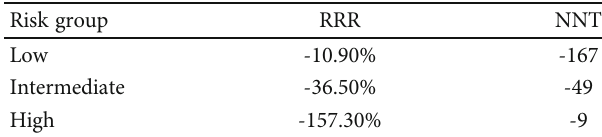
Table 13: Assessment of the utility of exposure to chemotherapy.